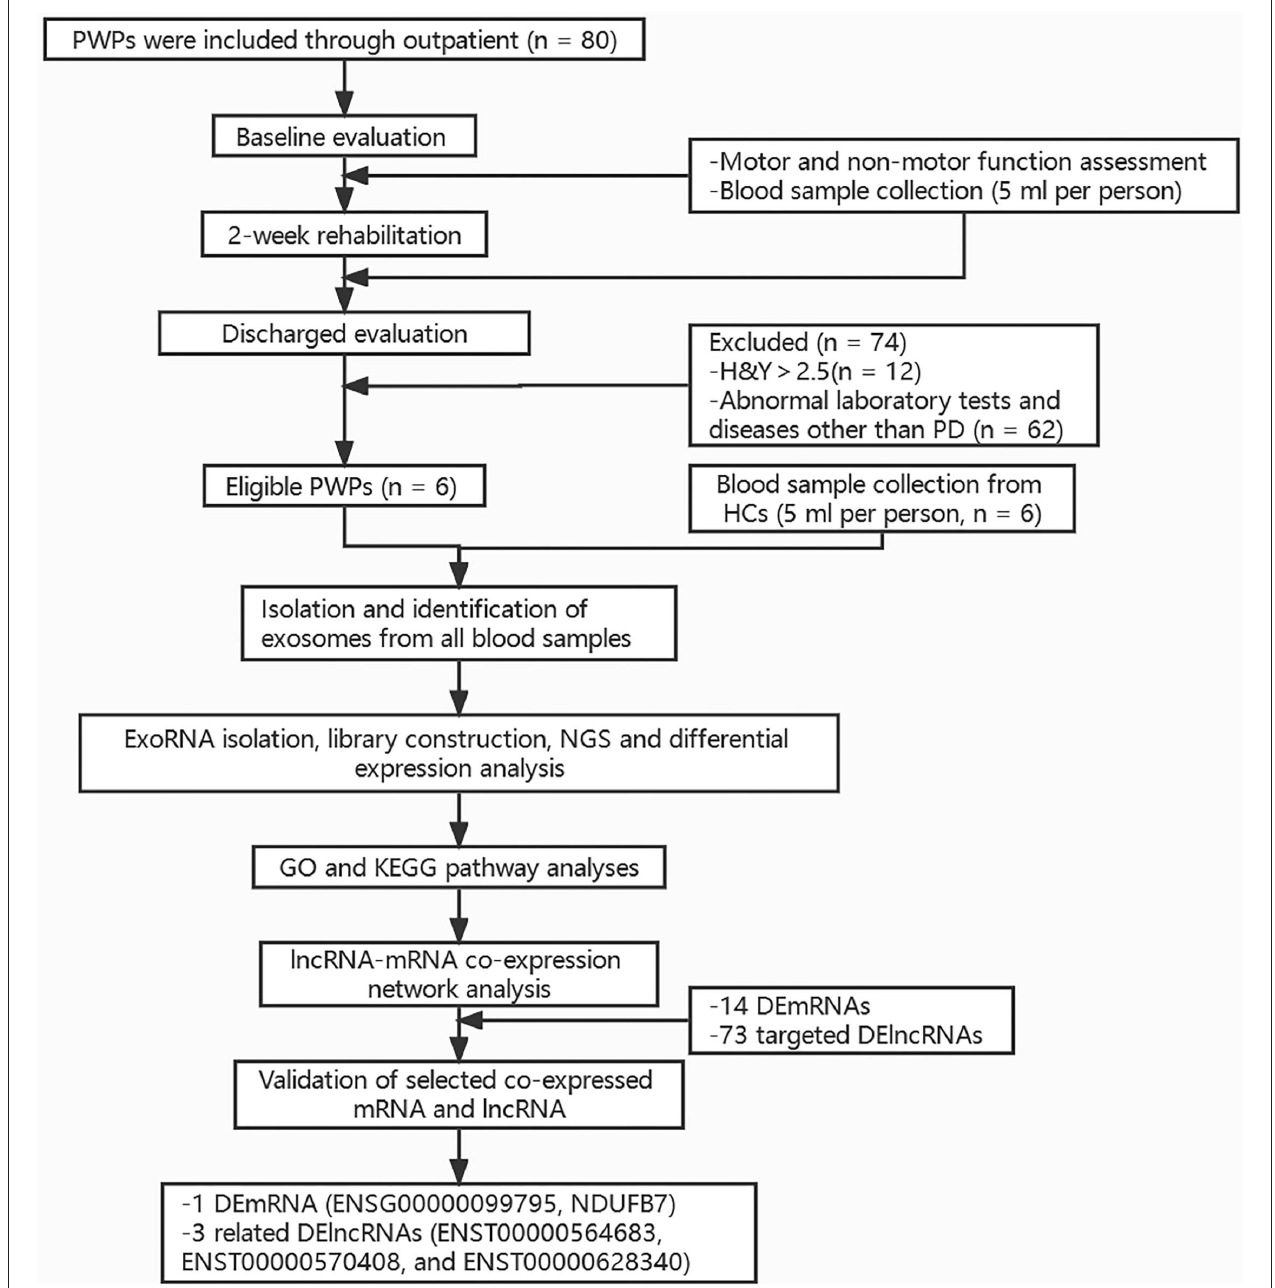
FIGURE 1 | Flow chart of the study. PWPs, patients with Parkinson’s disease; H and Y, Hoehn and Yahr; PD, Parkinson’s disease; HCs, healthy controls; NGS, Next-generation sequencing; GO, Gene ontology Ontology; KEGG, Kyoto Encyclopedia of Genes and Genomes; DEmRNAs, differentially expressed mRNAs; DElncRNAs, differentially expressed